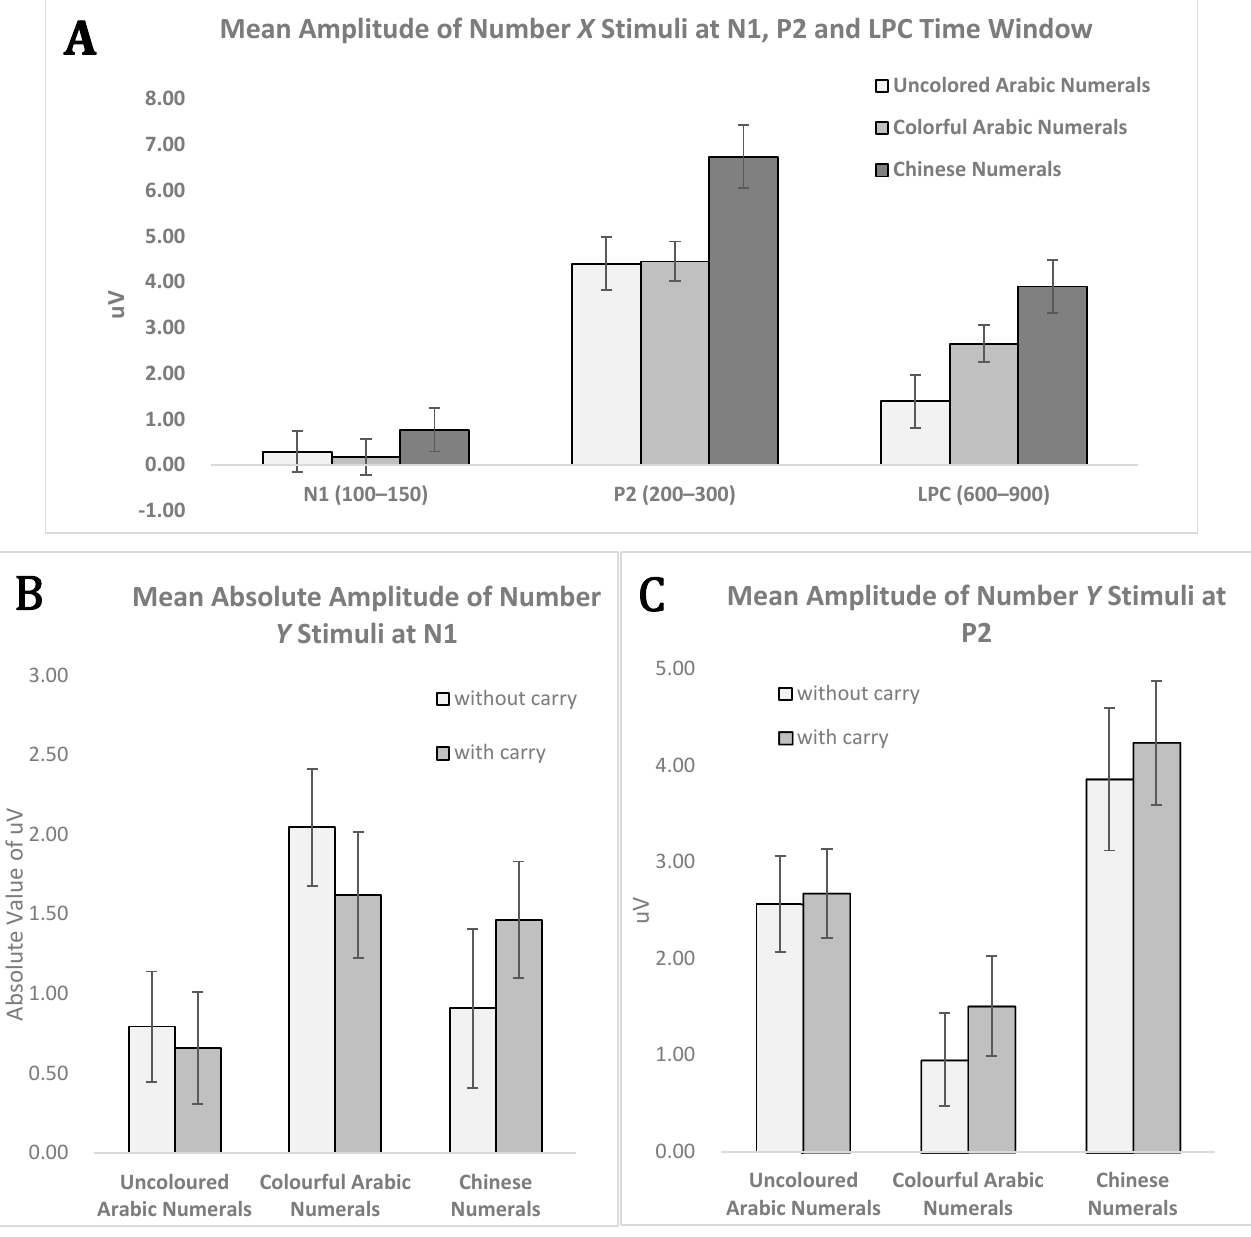
Figure 4. Mean amplitudes of ERP components (error bars indicate standard error). ( A ) Mean am-